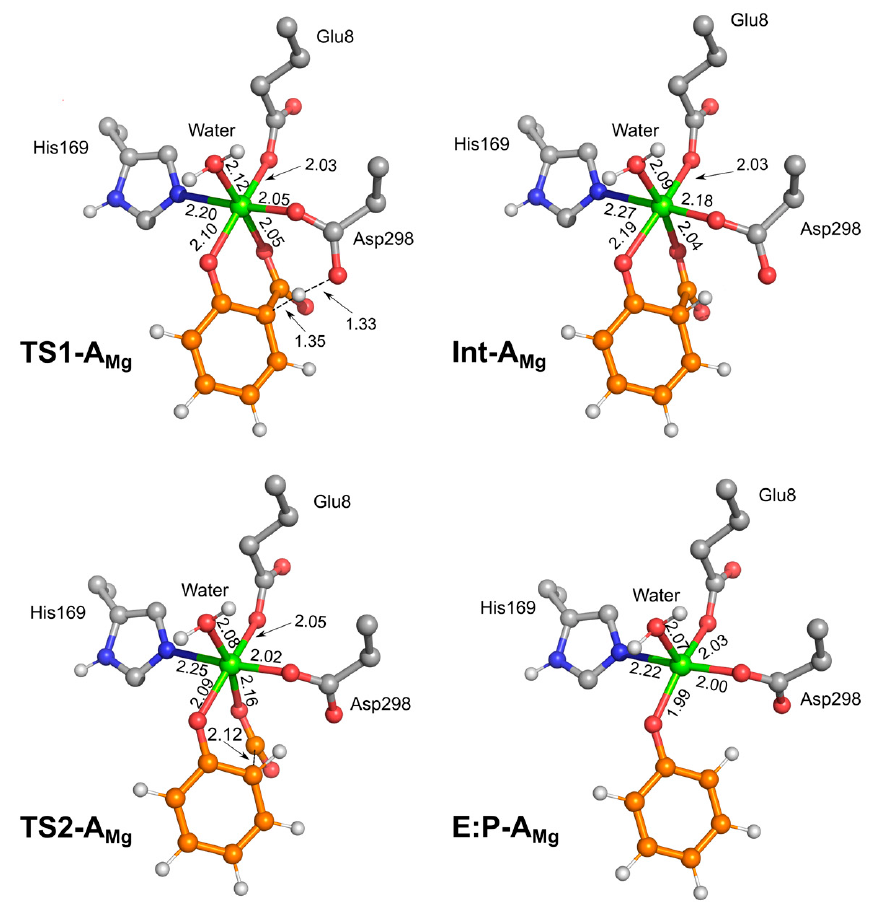
Figure 3. Optimized structures for the transition states ( TS1-A Mg and TS2-A Mg ) and intermediates ( Int-A Mg and E:P-A Mg ) in the reaction pathway of SDC. Only a part of the active site model is shown here. See Supplementary Materials for the structures with full models (Figures S1–S4).